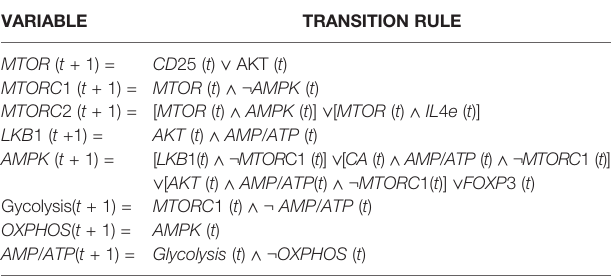
TABLE 1 | Boolean rules for the metabolism module. Here, ∨ ! or, ∧ ! and, while ¬ ! not. VARIABLE TRANSITION